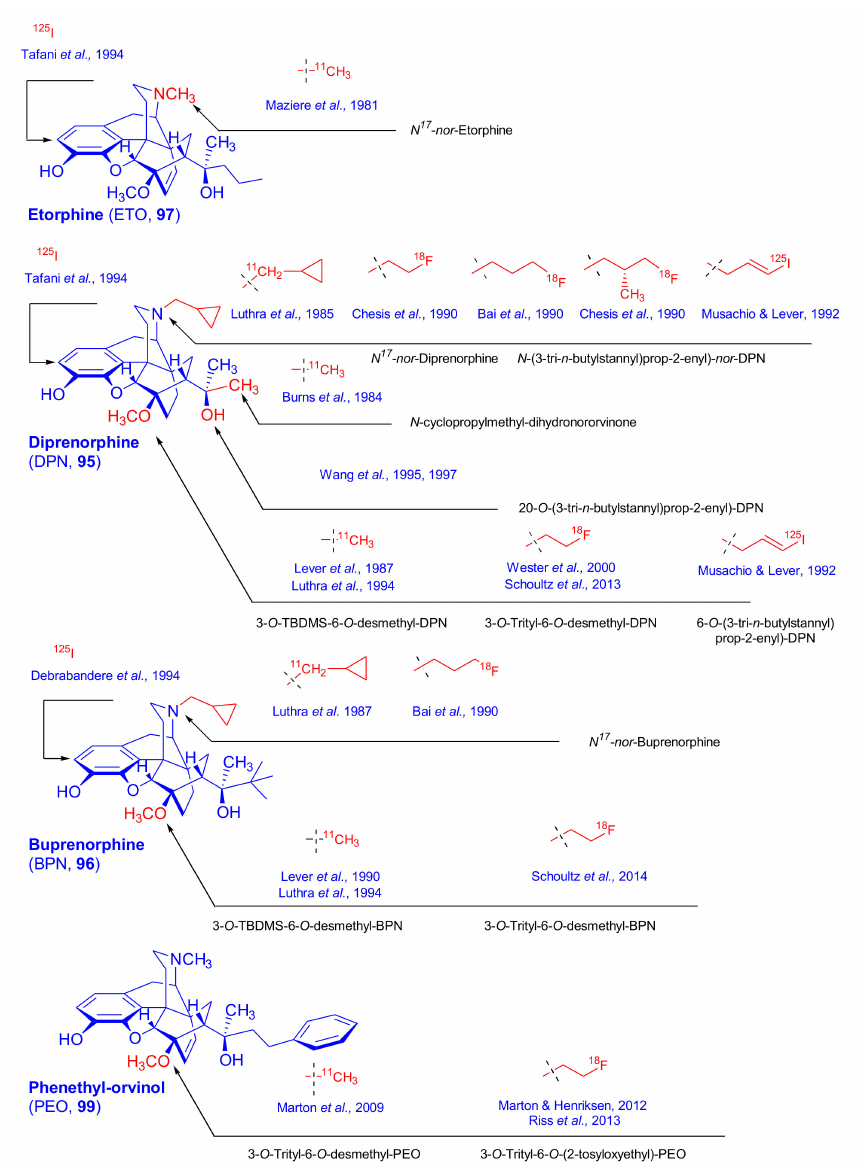
Figure 111. Strategies for the synthesis of radiolabeled orvinol